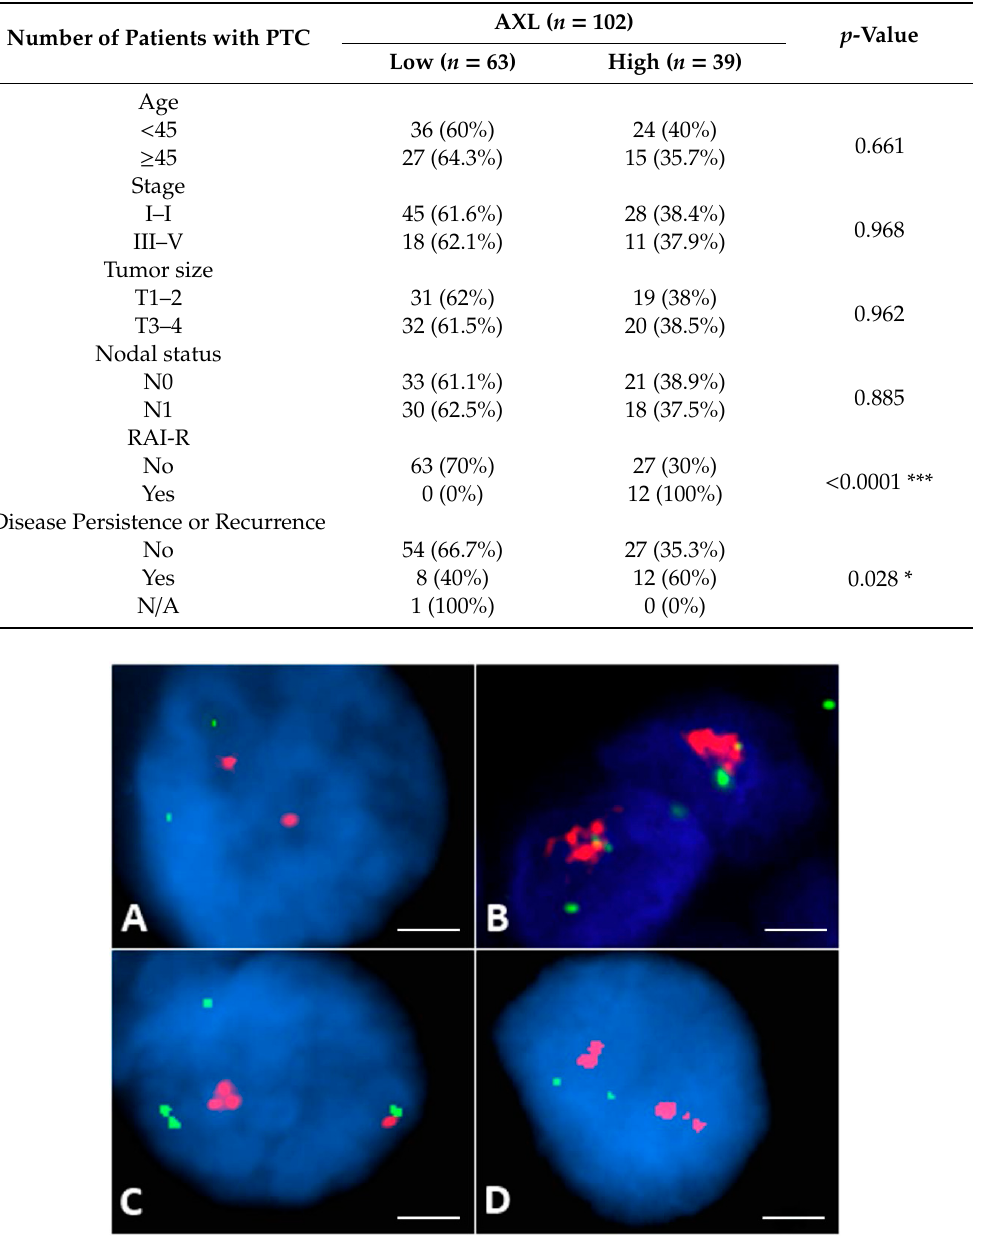
Table 1. Relation between AXL expression and clinico-pathologic features in the group of 102 patients. RAI-R = Radioactive Iodine-Refractoriness. * p ≤ 0.05; *** p ≤ 0.001.